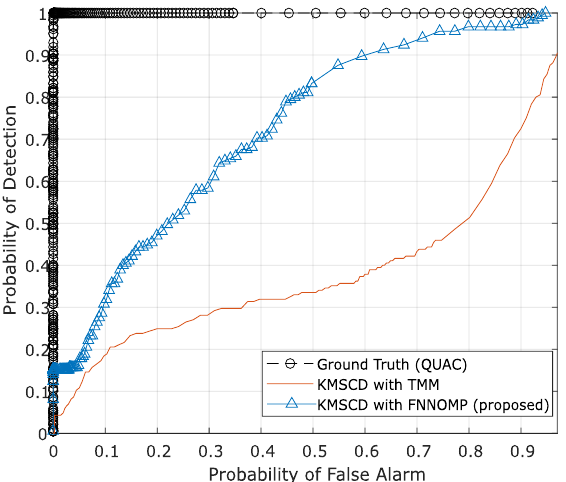
Figure 11. The ROC curve of Orange Perspex (OP) target material with adaptive cosine estimator (ACE). ACE detector that shows the better recovery of the trace materials (Orange Perspex) from the one reconstructed by the Algorithm 2 with an area under the curve (AUC) of 0.68, which is almost twice as that constrained by TMM (AUC =